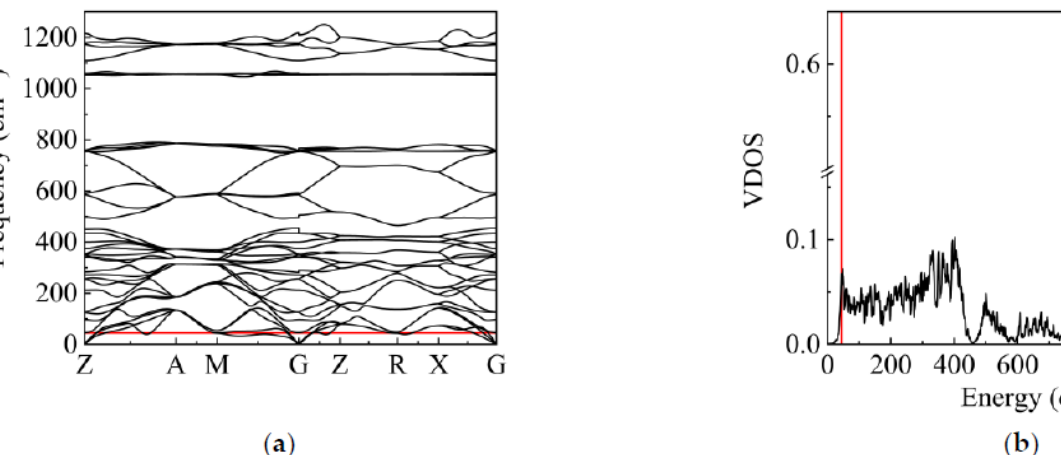
Figure 1. ( a ) The Phonon dispersion of α -Cristobalite. The red line is the frequency of the main peak at 44 cm − 1 . ( b ) The vibrational density of states (VDOS) of α -Cristobalite with harmonic approximation. The red line is the location of the main peak.